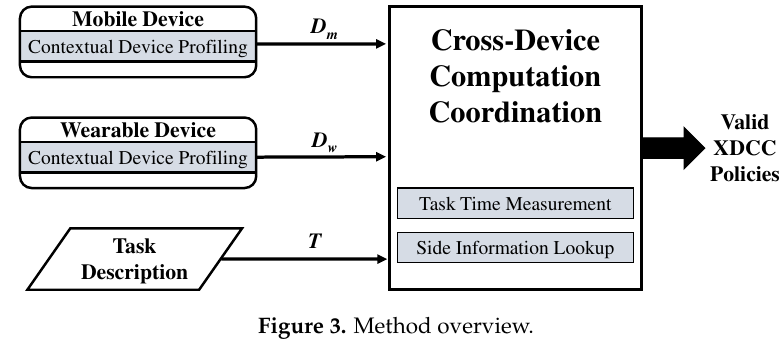
Figure 3. Method